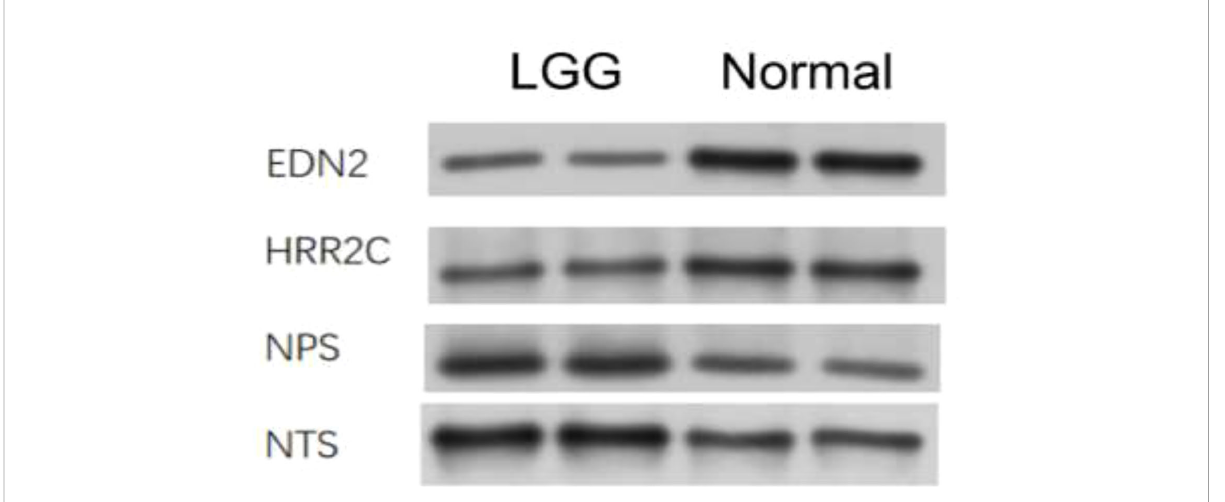
FIGURE 6 Western blot analysis on the expression of different genes in LGG cells and normal